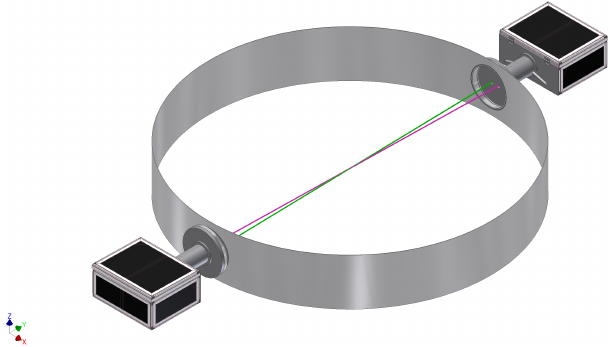
Figure 3. The SIMONE set-up at the CERN CLOUD chamber. The instrument consists of two boxes facing each other. One box houses the laser production and the backward scattered light detector and the other box houses the forward scattered light detector and a beam dump. The green line illustrates the path of the laser beam, which crosses the field of view (purple line) of the detection optics. The overlap region defines a detection volume of a few cubic centimetres volume in the centre of the